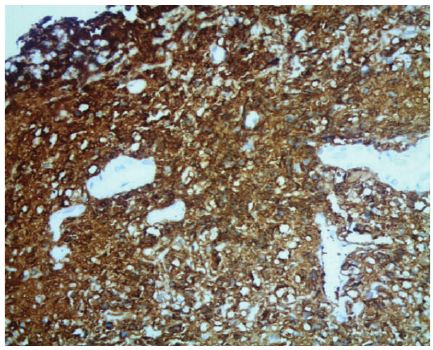
Figure 5: Photomicrograph of diffuse large B-cell lymphoma of ilium showing CD20 positive atypical lymphoid cells (CD20 stain, ×